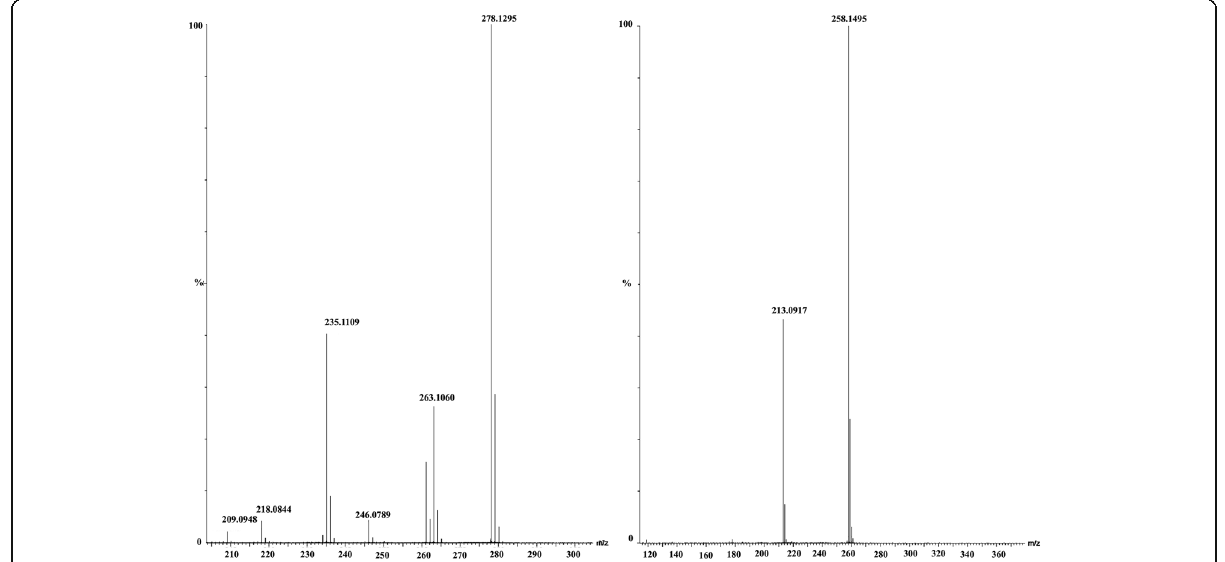
Fig. 3 UHPLC-Qtof mass spectrum of identified compounds from the chloroform extract. (1) m/z ratio: 278.1295 and (2) m/z ratio: